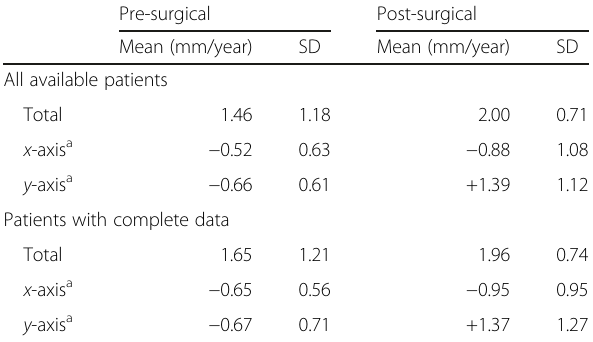
Table 3 Pre- (T2-T1) and post-surgical (T4-T3) changes in condylar position of the treatment group, with statistics for all 18 pre-surgical and 15 post-surgical patients shown above and for the 11 patients with complete data at all four time points shown below Pre-surgical